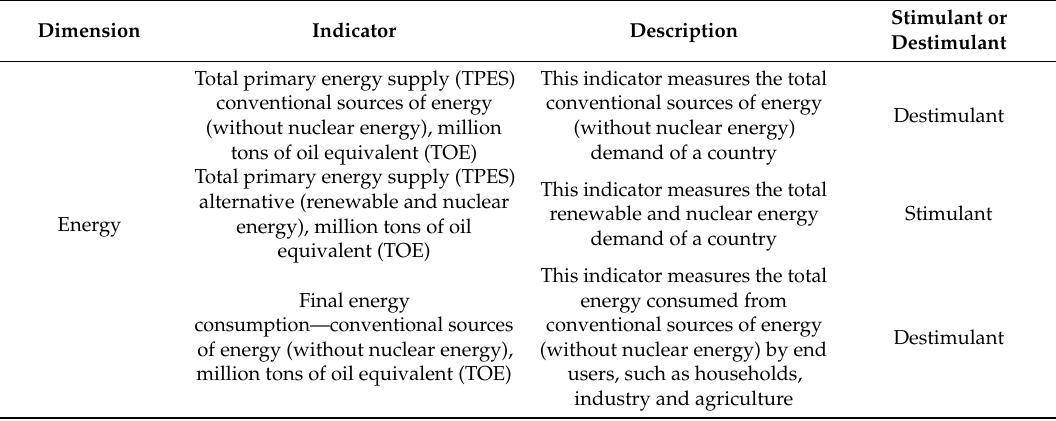
Table 2. Variables, units and explanation of statistical